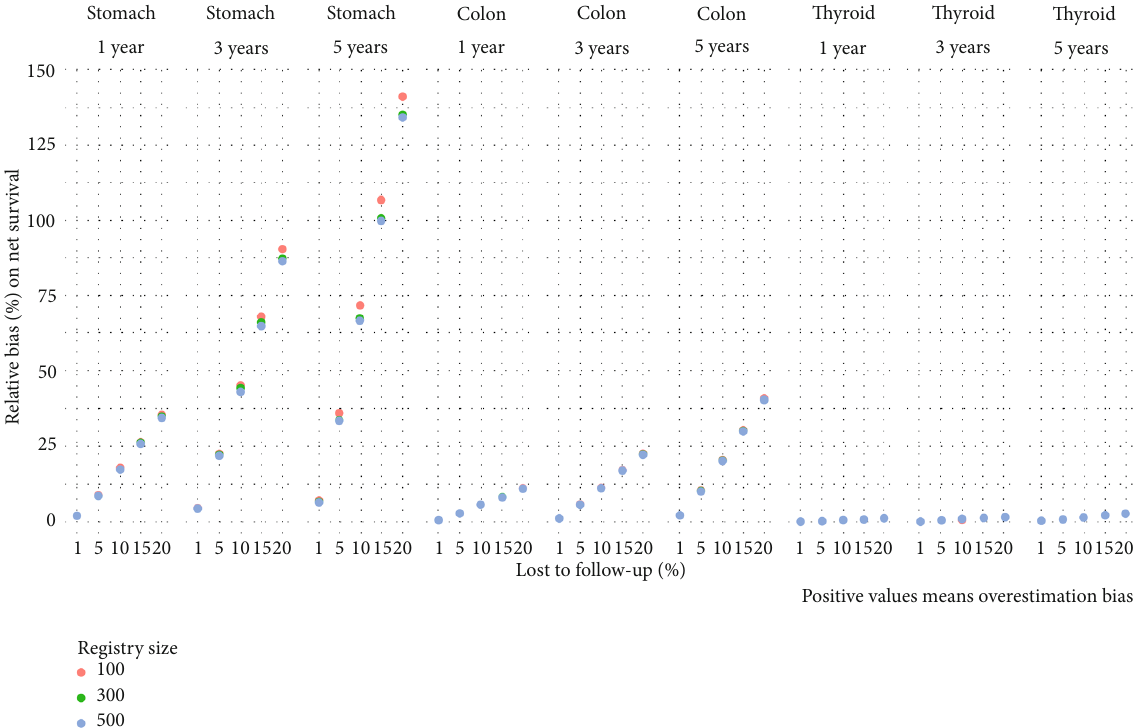
Figure 3: Relative bias (%) on net survival due to censoring lost to follow-up cases by cancer localization, follow-up time, percentage lost to follow-up, and registry